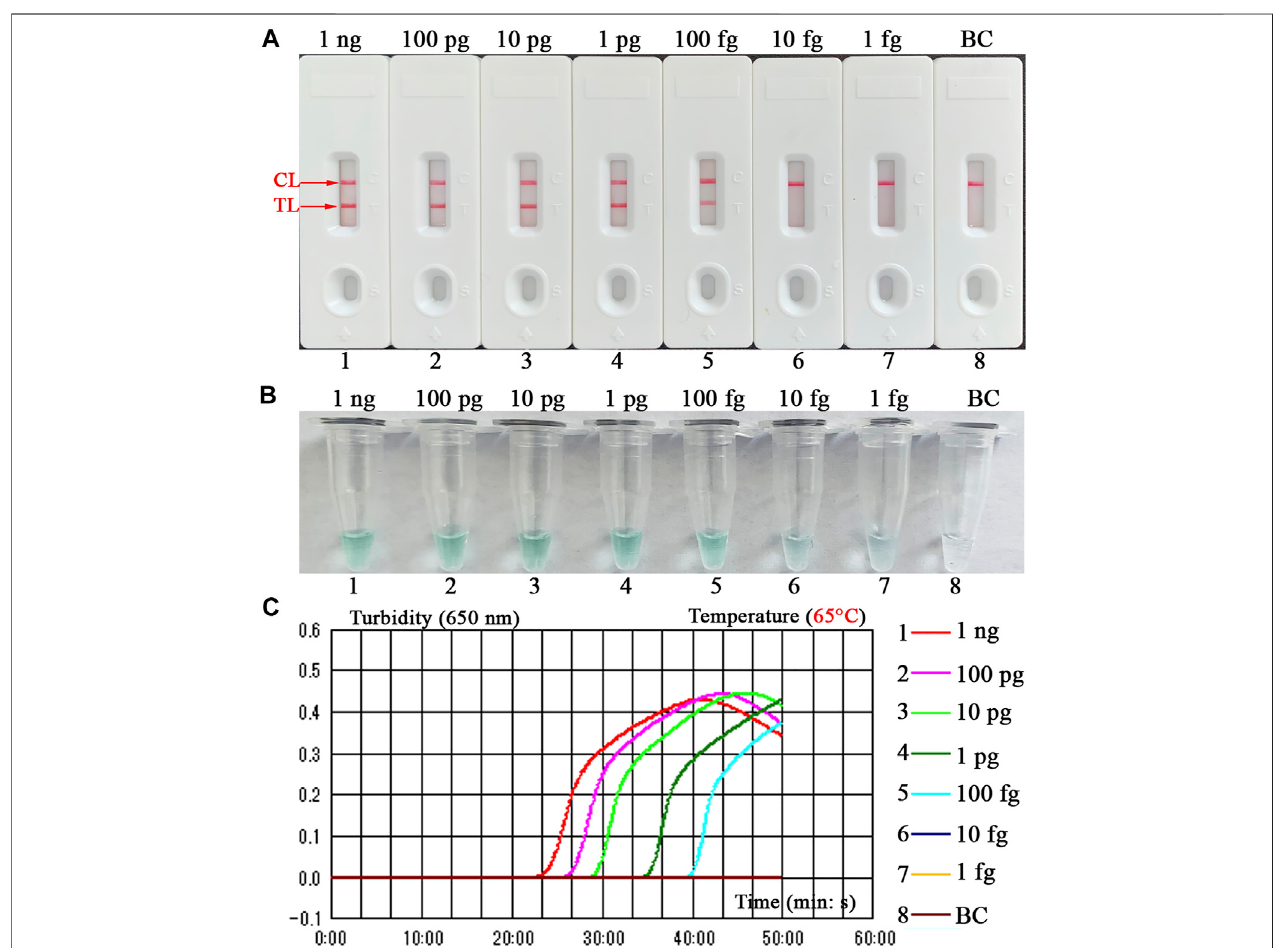
FIGURE 5 | Detection sensitivity for the B. abortus -LAMP-LFIA assay. The experiments were performed according to the optimal reaction condition, and serial dilutions (1 ng, 100 pg, 10 pg, 1 pg, 100 fg, 10 fg, and 1 fg per microliter) of target DNA template were tested. Three validation tools, containing LFIA strips (A) , MG reagents (B) , and real-time turbidity (C) , were used to verify the B. abortus- LAMP ampli fi cation products. Strips (A) /tubes (B) /curves (C) 1-7 correspond to DNA template of B. abortus 544 from 1 ng/ μ l to1 fg/ μ l, strip/tube/curve 8: blank control (ddH 2 O). MG, malachite green; LAMP, loop-mediated isothermal ampli fi cation; LFIA, lateral fl ow immunoassay biosensor; ddH 2 O, double distilled water; TL, test line; CL, control line. All tests were independently implemented in multiple replicates.